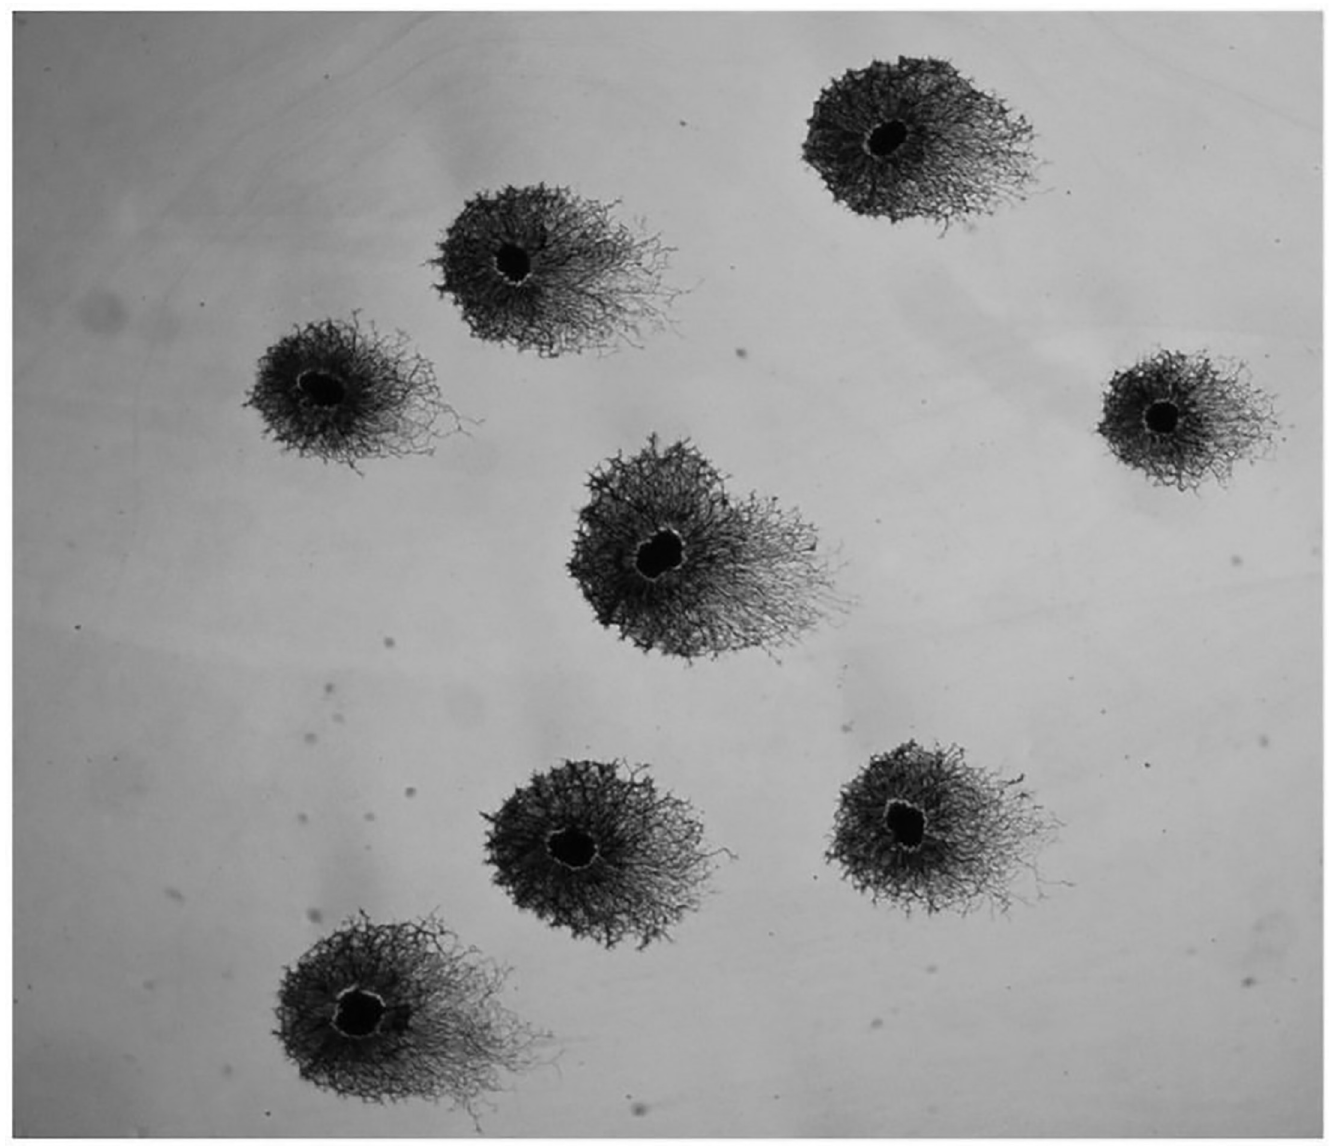
Fig 6. A field of silver-stained sympathetic explants exhibiting co-orientation of neurite halos. Each of the eight explants exhibits an asymmetric halo and the longest neurites within each halo extend to the right side of the field. Such co-orientation of halos was a common occurrence among neighboring explants although there was no consistent orientation from one culture dish to